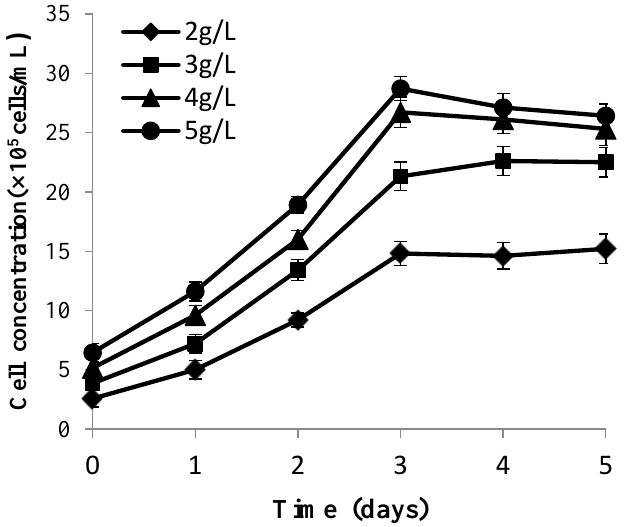
Figure 5. Growth curve of CPB cells at different microcarrier concentrations. Bars show the mean ± SD, n = 3. Table 2. Cell expansion fold and specific growth rate at different microcarrier concentrations.